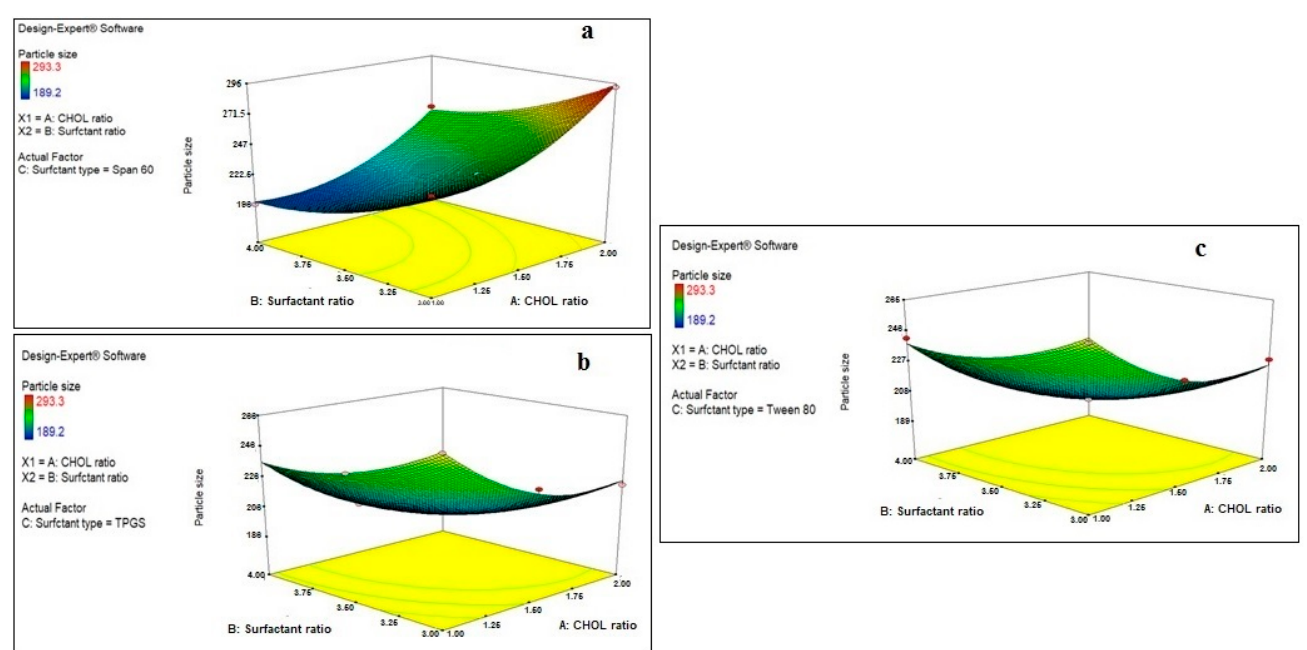
Figure 1. Effect of CHOL and surfactant ratio on the particle size of drug-free niosomes at different surfactant types (( a ): Span 60, ( b ): TPGS, ( c ): Tween 80).